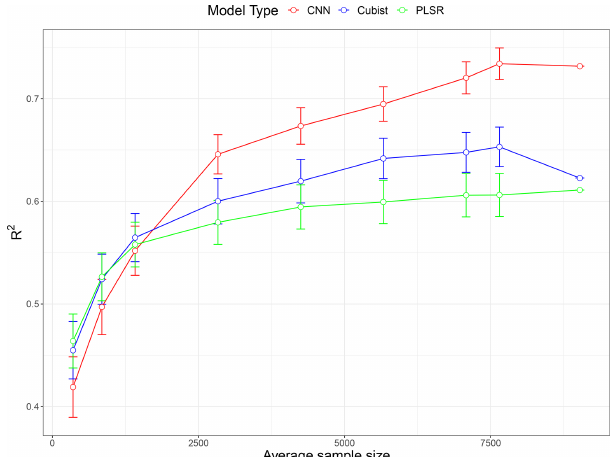
Figure 6. Model performances (in terms of average R 2 for five soil properties) as a function of sample size using partial least squares regression (PLSR), Cubist and convolutional neural network (CNN) models based on 10 simulations. The value for the largest sample size ( N = 9027) is a single realisation 75% of the